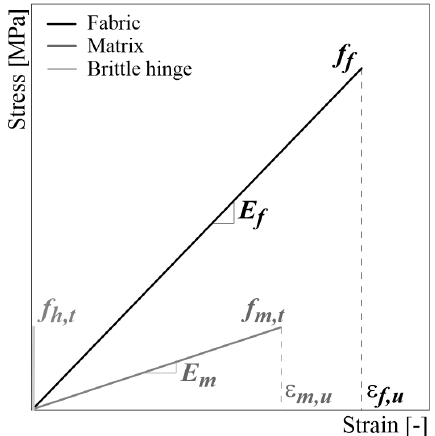
Figure 3. Constitutive laws assumed for material